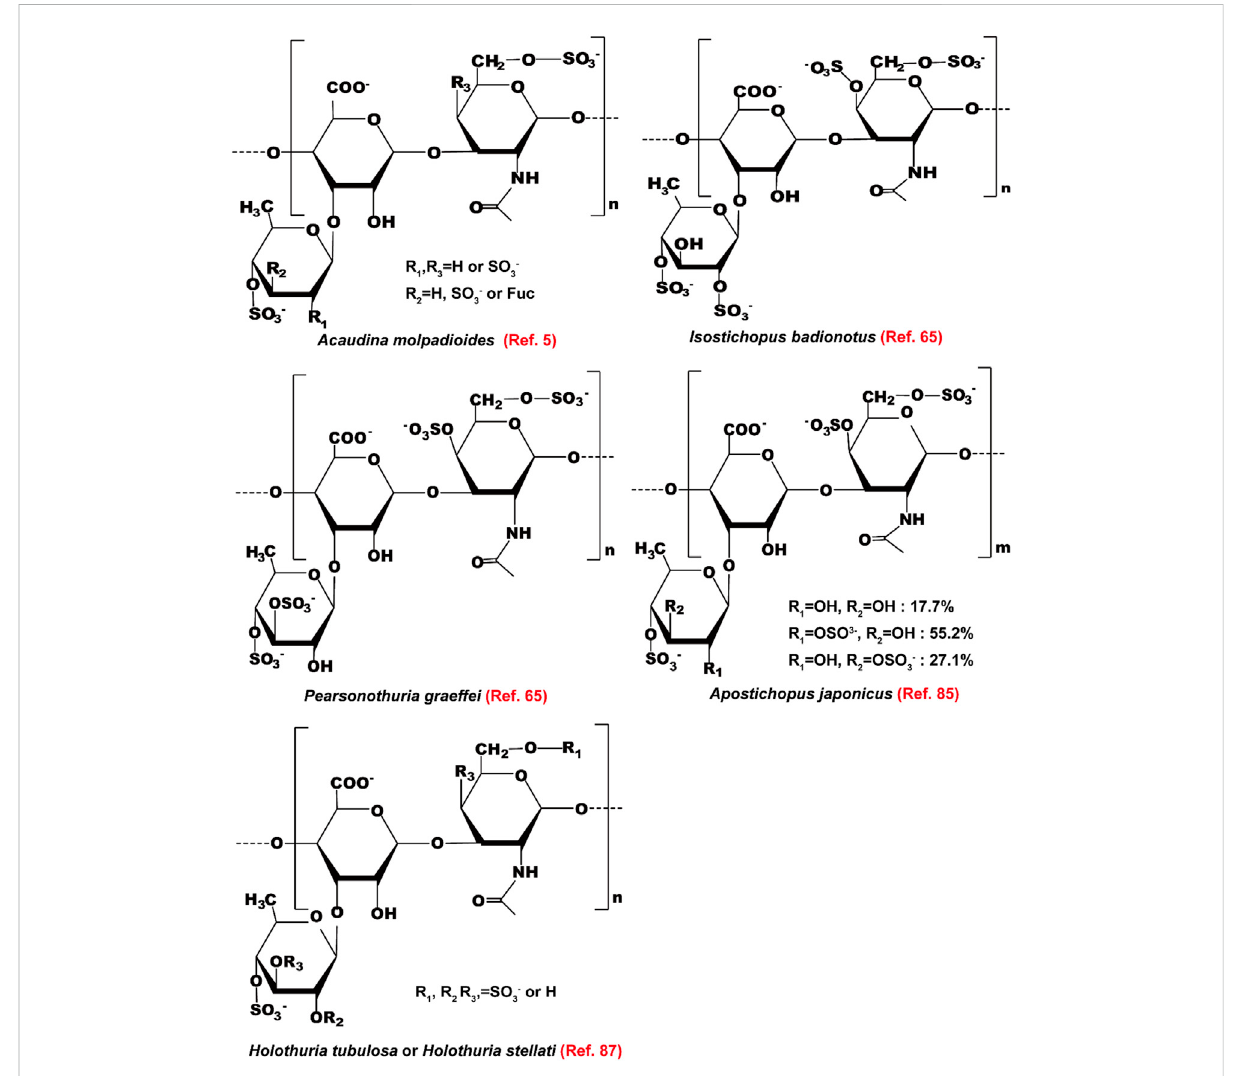
FIGURE 7 The structure of fucosylated chondroitin sulfates extracted from different sea cucumbers.